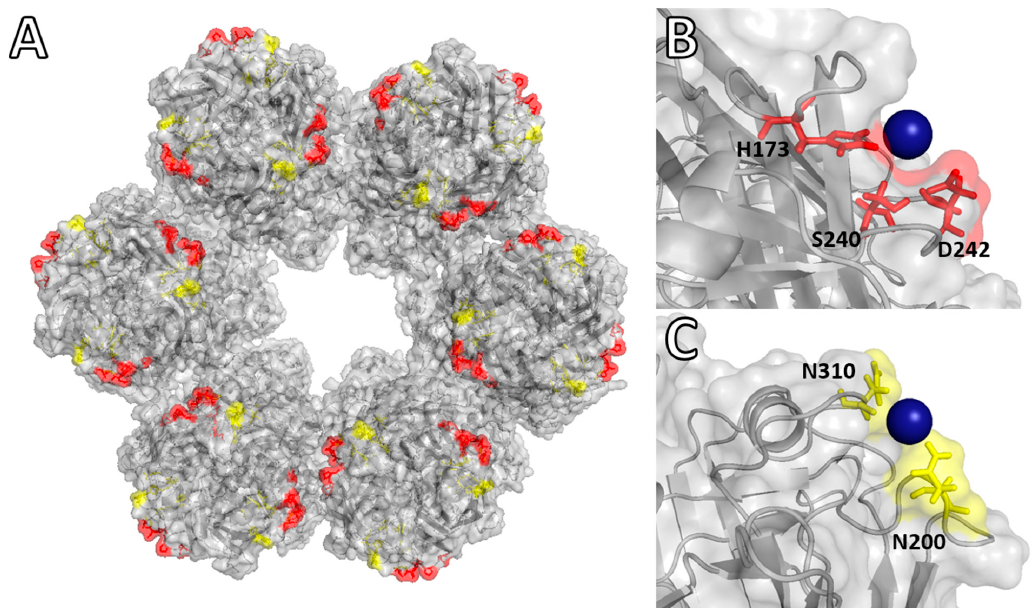
Figure 1. Molecular docking VP6 trimer with Pd(II) ions. ( A ) Hexamer of six trimers of VP6, indicating binding sites for PdCl 3 (H 2 O) − at pH 5.0 (red) and pH 8.0 (yellow). ( B ) Pd(II) binding site at pH 5.0. ( C ) Pd(II) binding site at pH 8.0. Molecular modeling with UCSF Chimera v1.10 and PyMOL V1.5 (Schröndinger) with PDB files 1QHD, 3N09, and 3IYU [24–26].